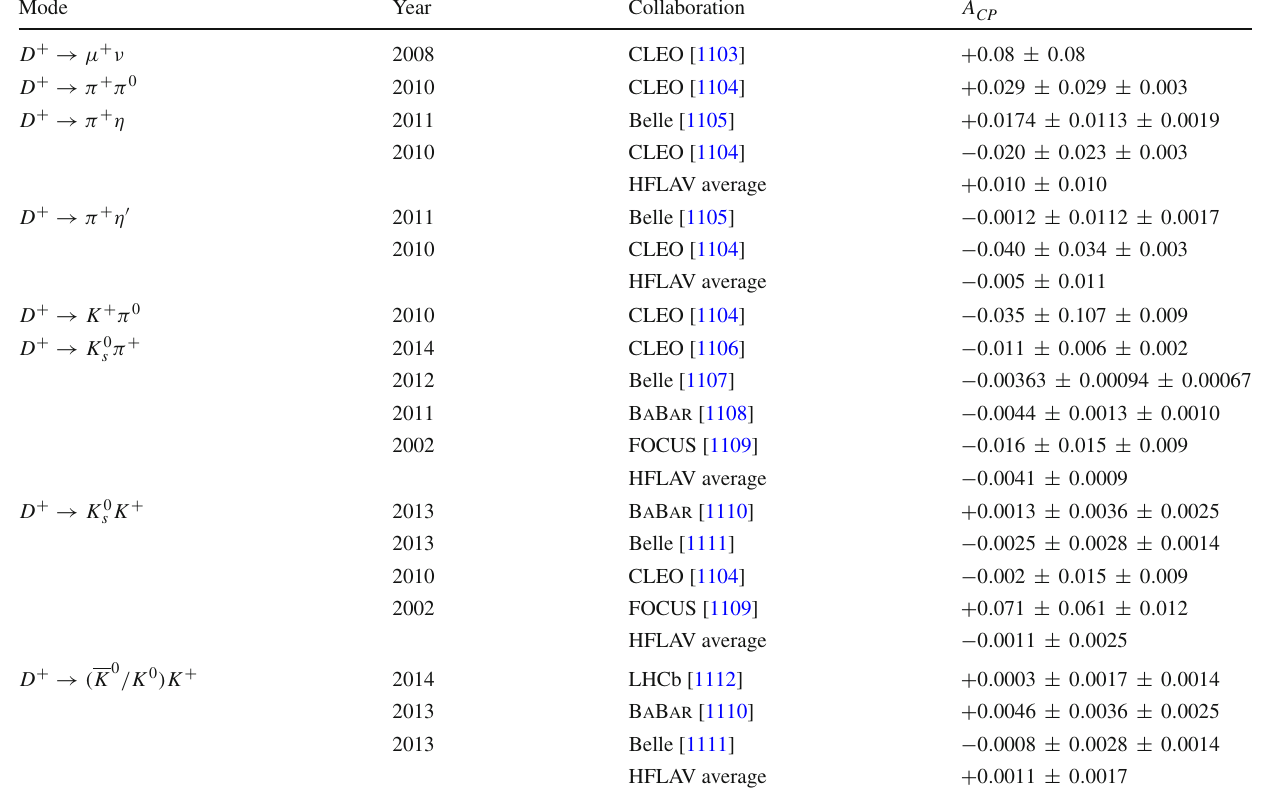
= [ (cid:6)( D + ) − (cid:6)( D − ) ] / [ (cid:6)( D + ) + (cid:6)( D − ) ] for two-body D ± decays Table 264 CP asymmetries A CP